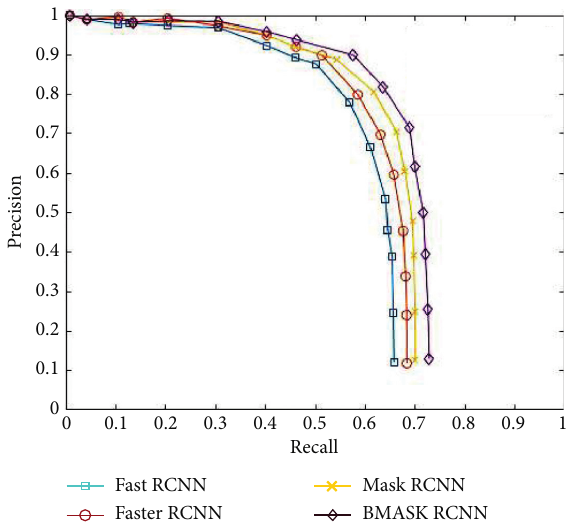
Figure 9: Curve comparative chart of precision and